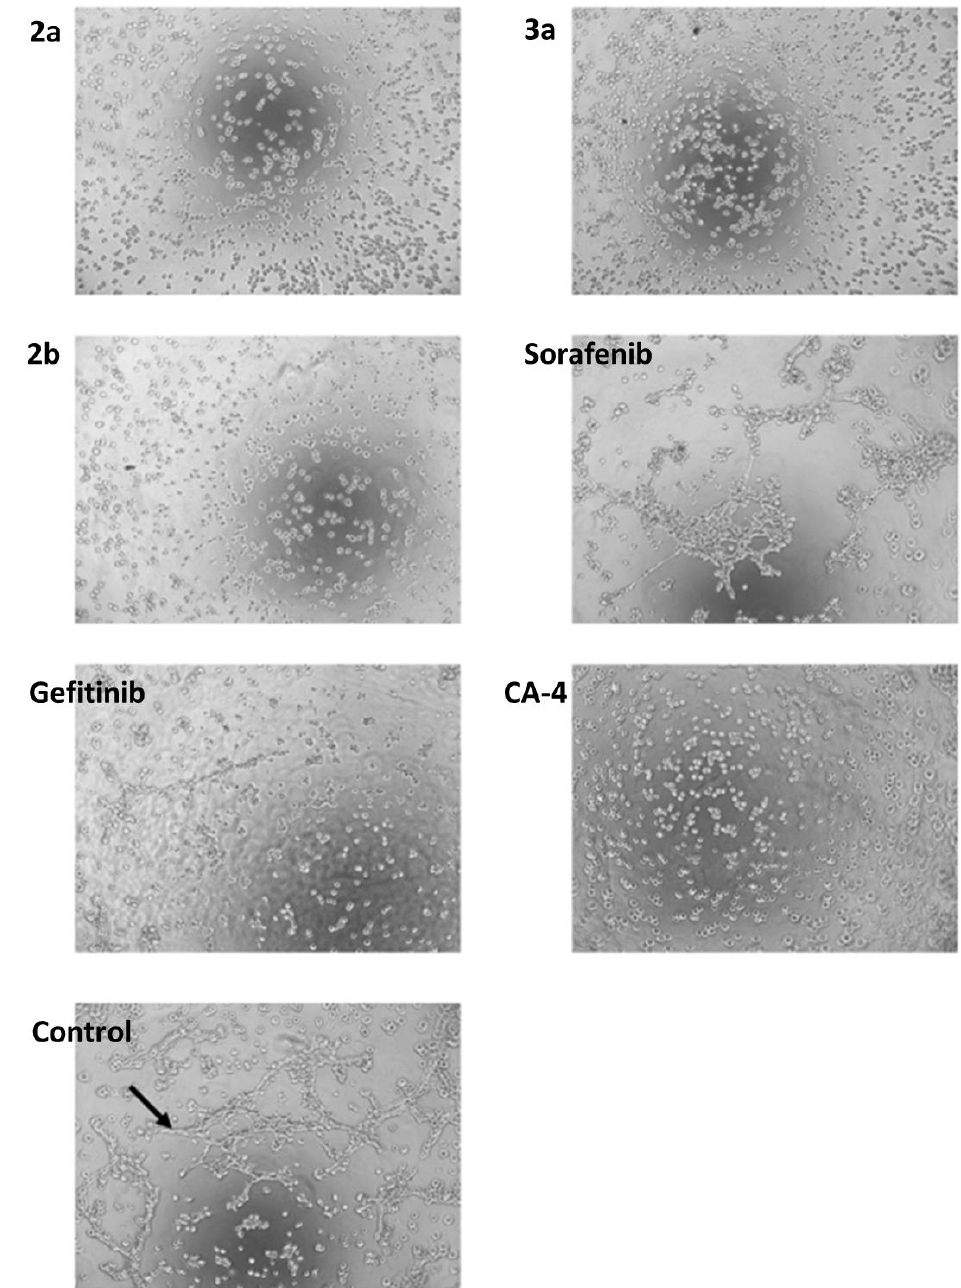
Figure 10. Suppression of tube formation by EaHy.926 cells upon treatment with 2a , 2b and 3a (5 μ M) for 6 h. Sorafenib (5 μ M), gefitinib (5 μ M), and combretastatin A-4 (CA-4, 10 nM) were used as for 6 h. Sorafenib (5 µ M), gefitinib (5 µ M), and combretastatin A-4 (CA-4, 10 nM) were used as positive controls. positive